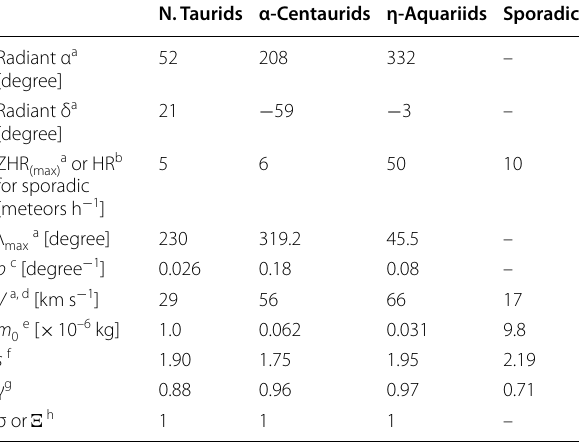
Besides these parameters, we set the detection limit to be 4 luminous energy of lunar impact flash sources and the conversion efficiency